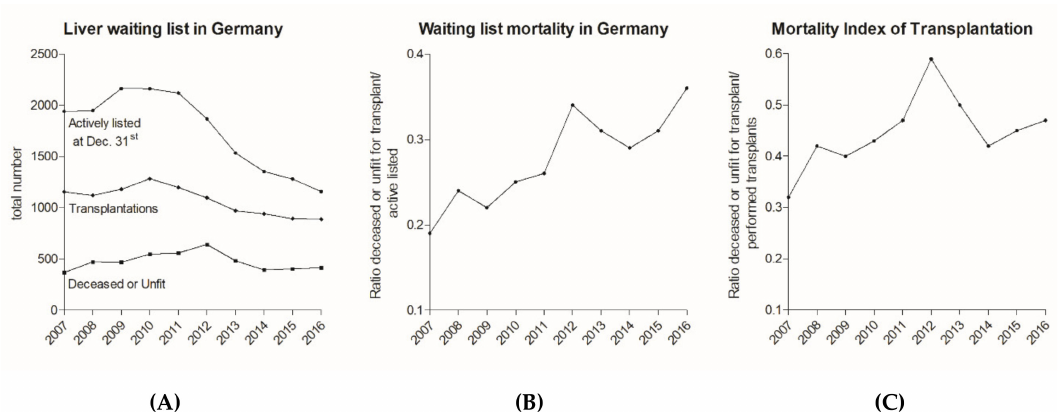
Figure 4. Liver transplant waiting list and waiting list mortality in Germany. While numbers of liver transplantations and actively listed patients on the liver waiting list have drastically declined since 2010, the number of removals from waiting list due to death or “unfit for transplantation” (summarized as waiting list mortality) remained stable in the investigated period ( A ). The ratio of these removals to actively listed patients increased. We found this increase in waiting list mortality to be significant ( B ) (Spearman’s rho = 0.903; p < 0.001, CI = 0.634–0.977). The mortality index of transplantation showed a similar development ( C ) (Spearman’s rho = 0.527; p = 0.117, CI = − 0.153–0.868). Source: Annual Reports of Eurotransplant.